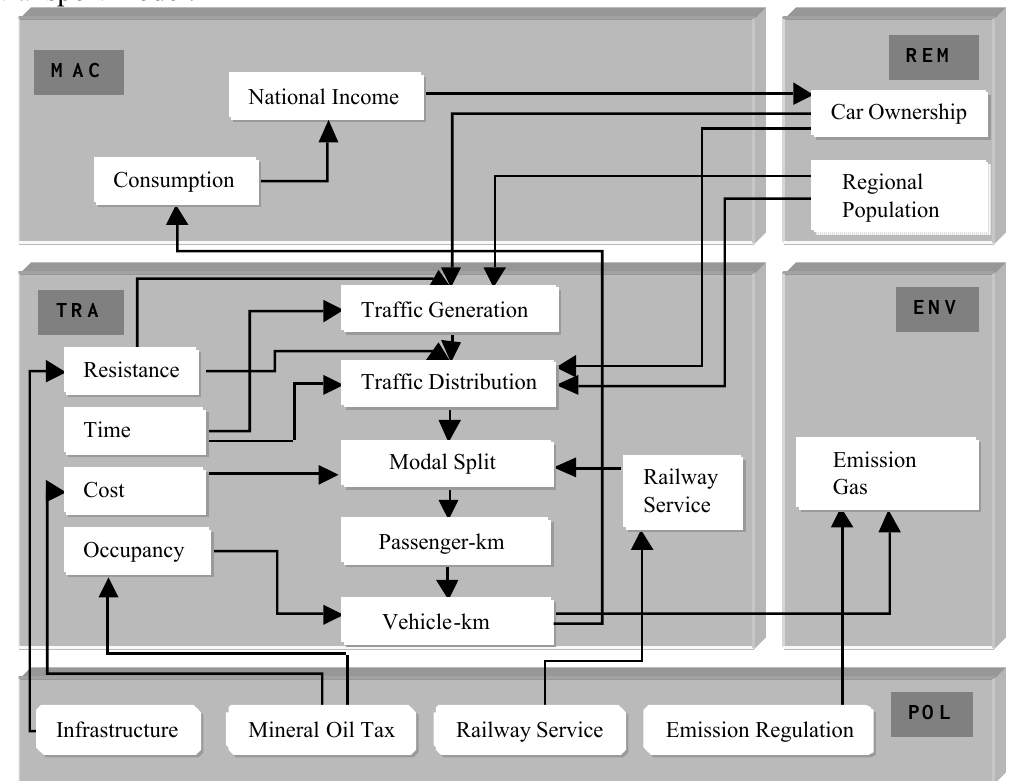
Figure 5. Passenger Transport in